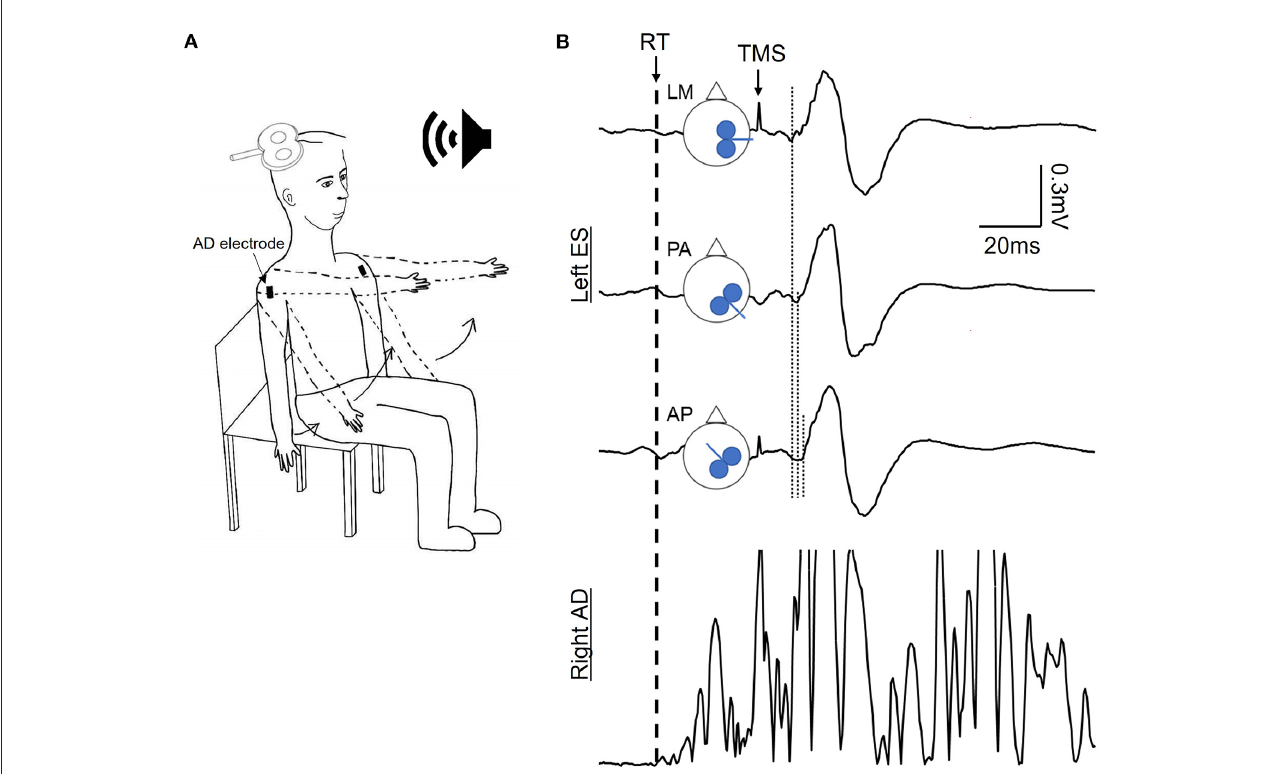
FIGURE1 Experimental setup. (A) Schematic of the dynamic shoulder flexion (DSF) task initiated in response to a verbal cue. (B) Schematic of coil orientation of the transcranial magnetic stimulation (TMS) and examples of motor evoked potentials (MEPs) averaged from 15 MEPs in the contralateral erector spinae (ES) muscle and rectified EMG traces in the anterior deltoid (AD) during the DSF task. Dash line indicating the reaction time of the DSF task according to the EMG onset of AD; dotted lines indicating the onset latency of ES MEP elicited by the TMS coil oriented to induce the latero-medial (LM), posterior-anterior (PA), and anterior-posterior (PA) currents in the brain. Note that the MEP latency elicited by the AP and PA currents were longer compared with the LM